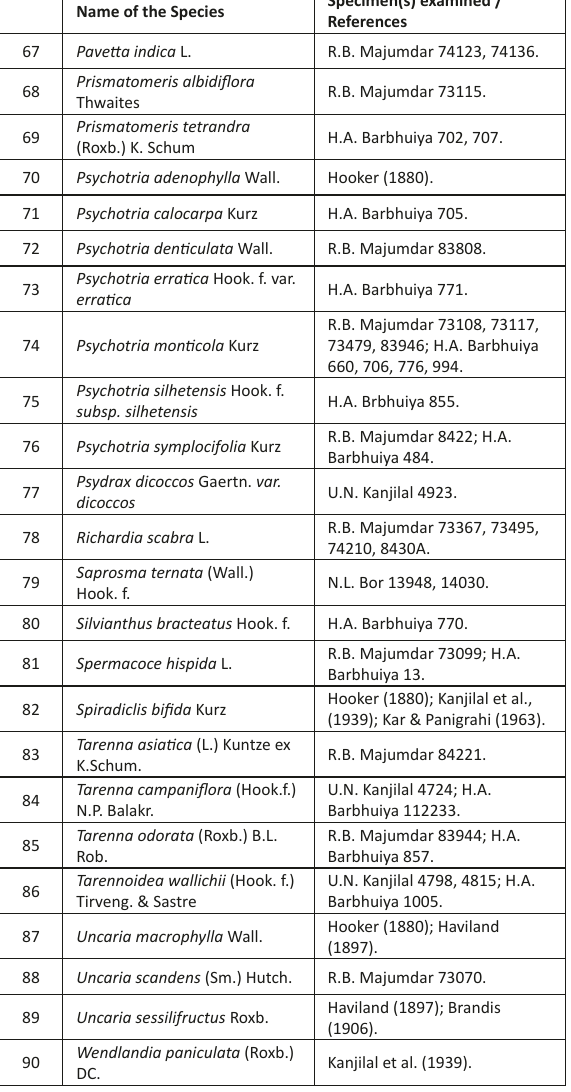
was collected by R.L. Keenan from Cachar District of the entire southern Assam was surveyed, but it could not be located. Therefore, following IUCN Red List Categories Regionally Extinct